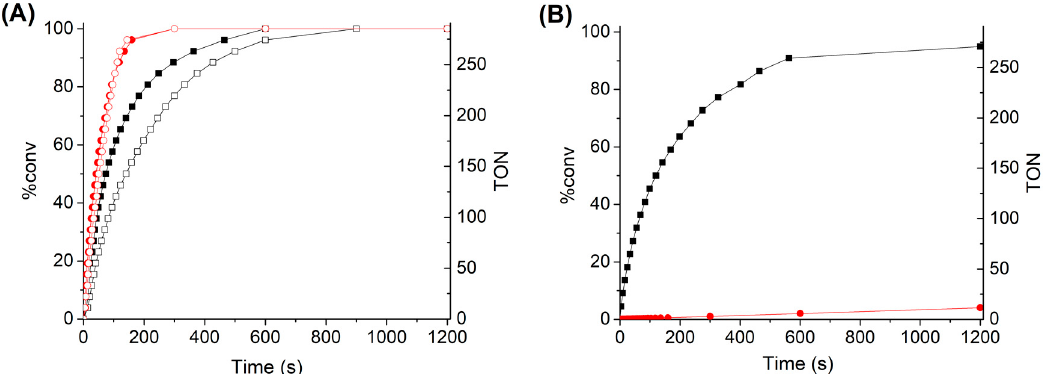
Figure 6. Percentage of H 2 O 2 decomposed (% of conv.) over time for: ( A ) MSN-4a ( ■ ) and MSN-4b ( □ ) in CH 3 CN and MSN-4a ( ● ) and MSN-4b ( ○ ) in H 2 O; ( B ) free-Mn-cat in CH 3 CN ( ■ ) and in H 2 O ( ● ).